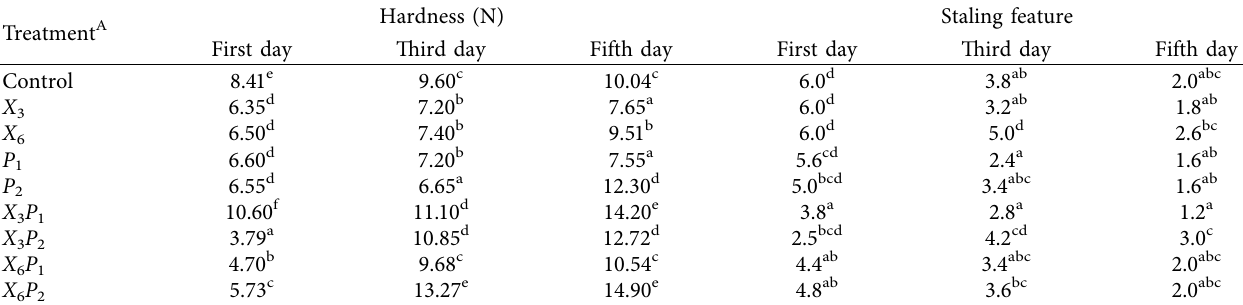
Table 5: Hardness and staling feature of baguette bread samples on the first, third, and fifth days of storage time. Treatment A